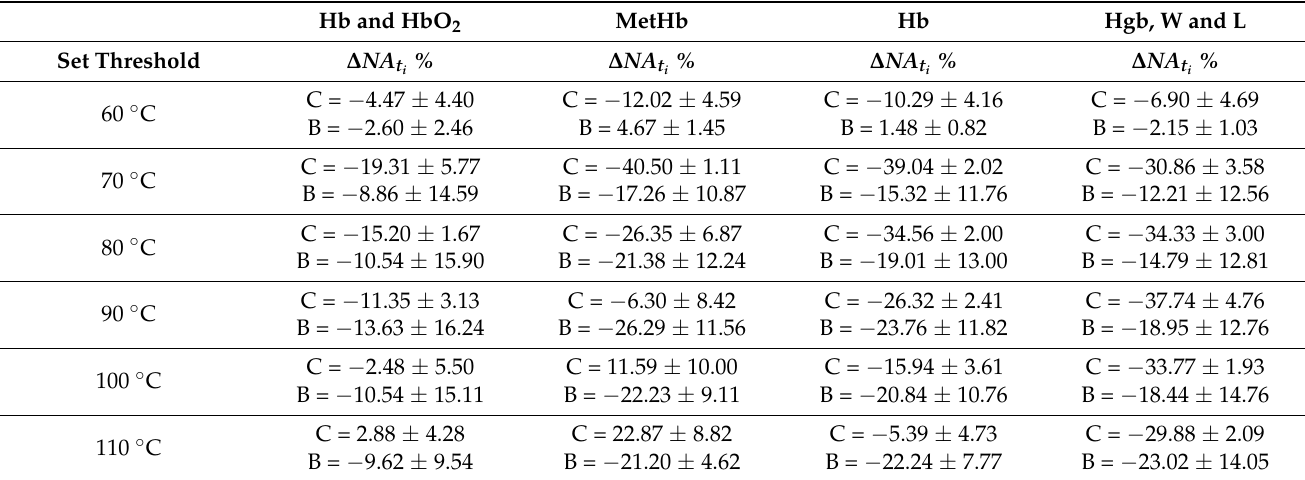
Table 1. Normalized area variations (%) measured during the laser ablation for the center (C) and the boundary (B) of the lesion. Reported values are obtained averaging results for the two